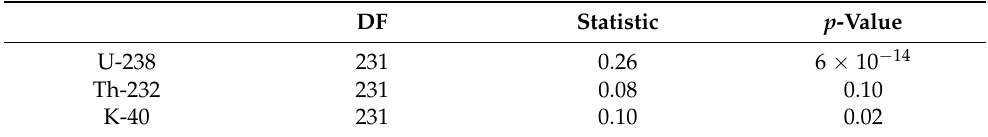
Table 5. Normality test using